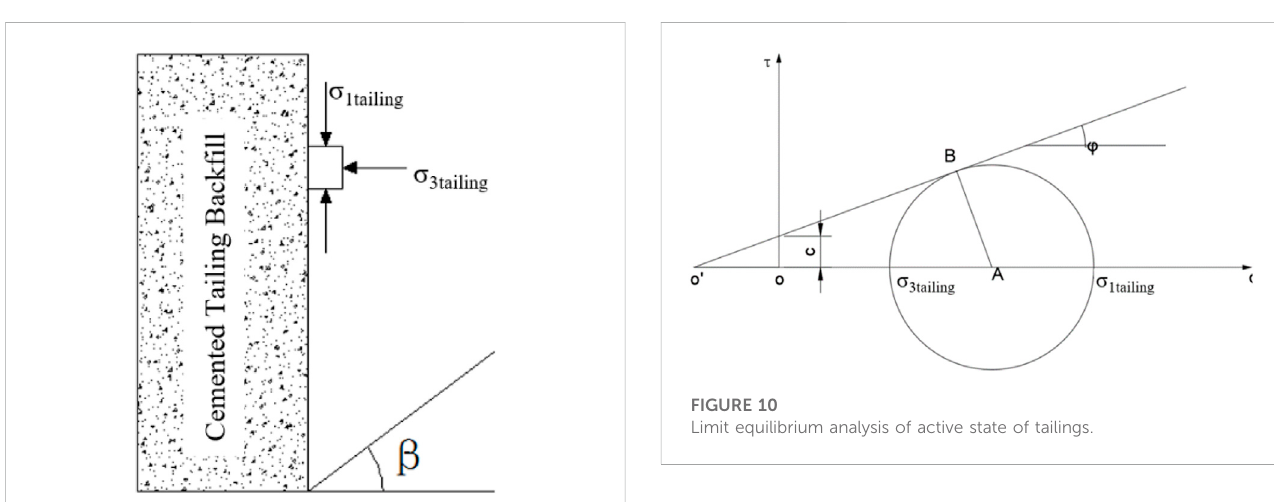
FIGURE 9 Tailings active pressure diagram.